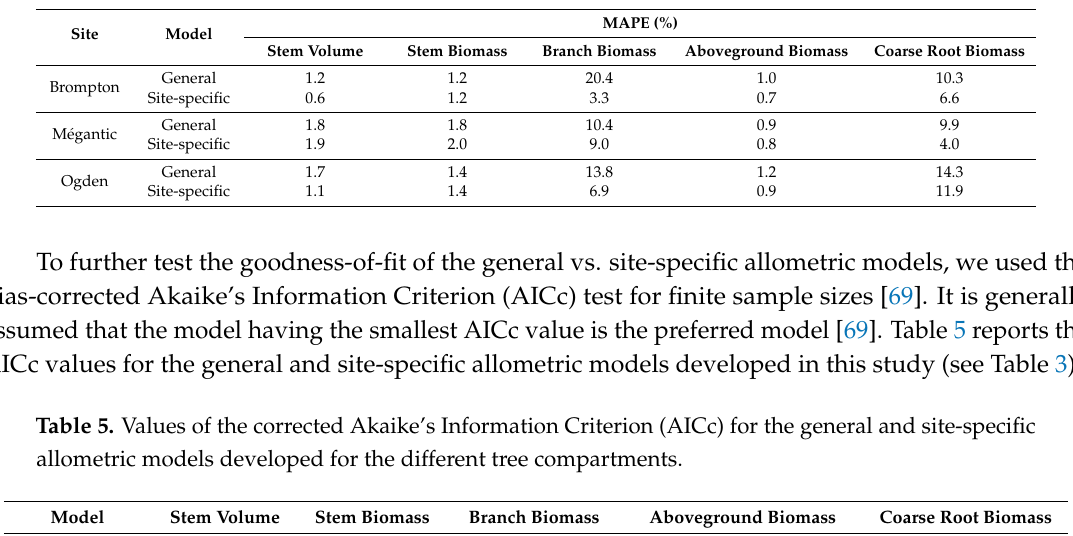
Table 4. Prediction error of site-specific vs. the general allometric relationships for different tree compartments. The prediction error was calculated as the mean absolute percentage error (MAPE).